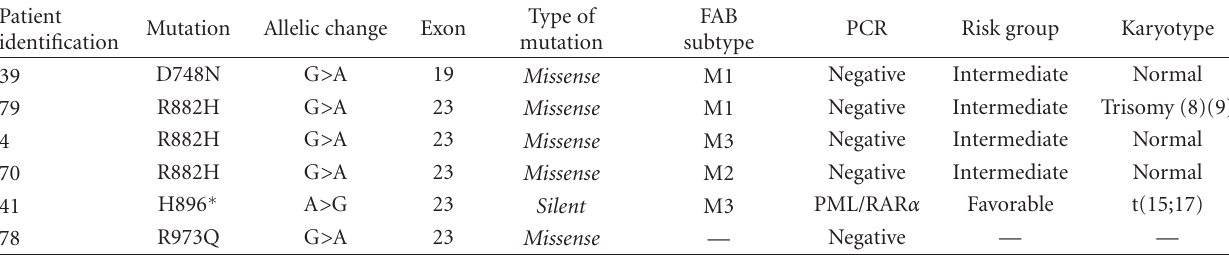
Figure 2: (a) Overall survival in a followup of 120 months with an estimated probability of overall survival of 41.7%; (b) disease-free survival in a followup of 120 months with an estimated probability of disease-free survival of 23.4%. Table 4: Description of somatic mutations found in gene